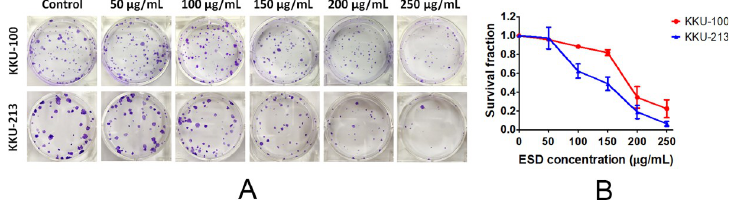
Fig 4. Colony formation assay, the effect of ESD treatment on cancer cells for 48 hrs. Photographs of 6-well plates in a representative experiment are shown in (A). Survival fractions for ESD treatment (B) were normalized by dividing by the survival fractions for untreated cells.